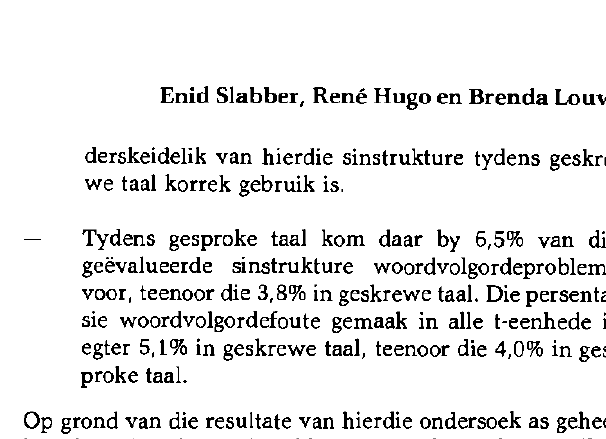
des se woordvoigordegebruik met die van die gehoorge- stremde kind vergelyk word, kan woordvolgordeprobleme aan die hand van die volgende verklaar word: